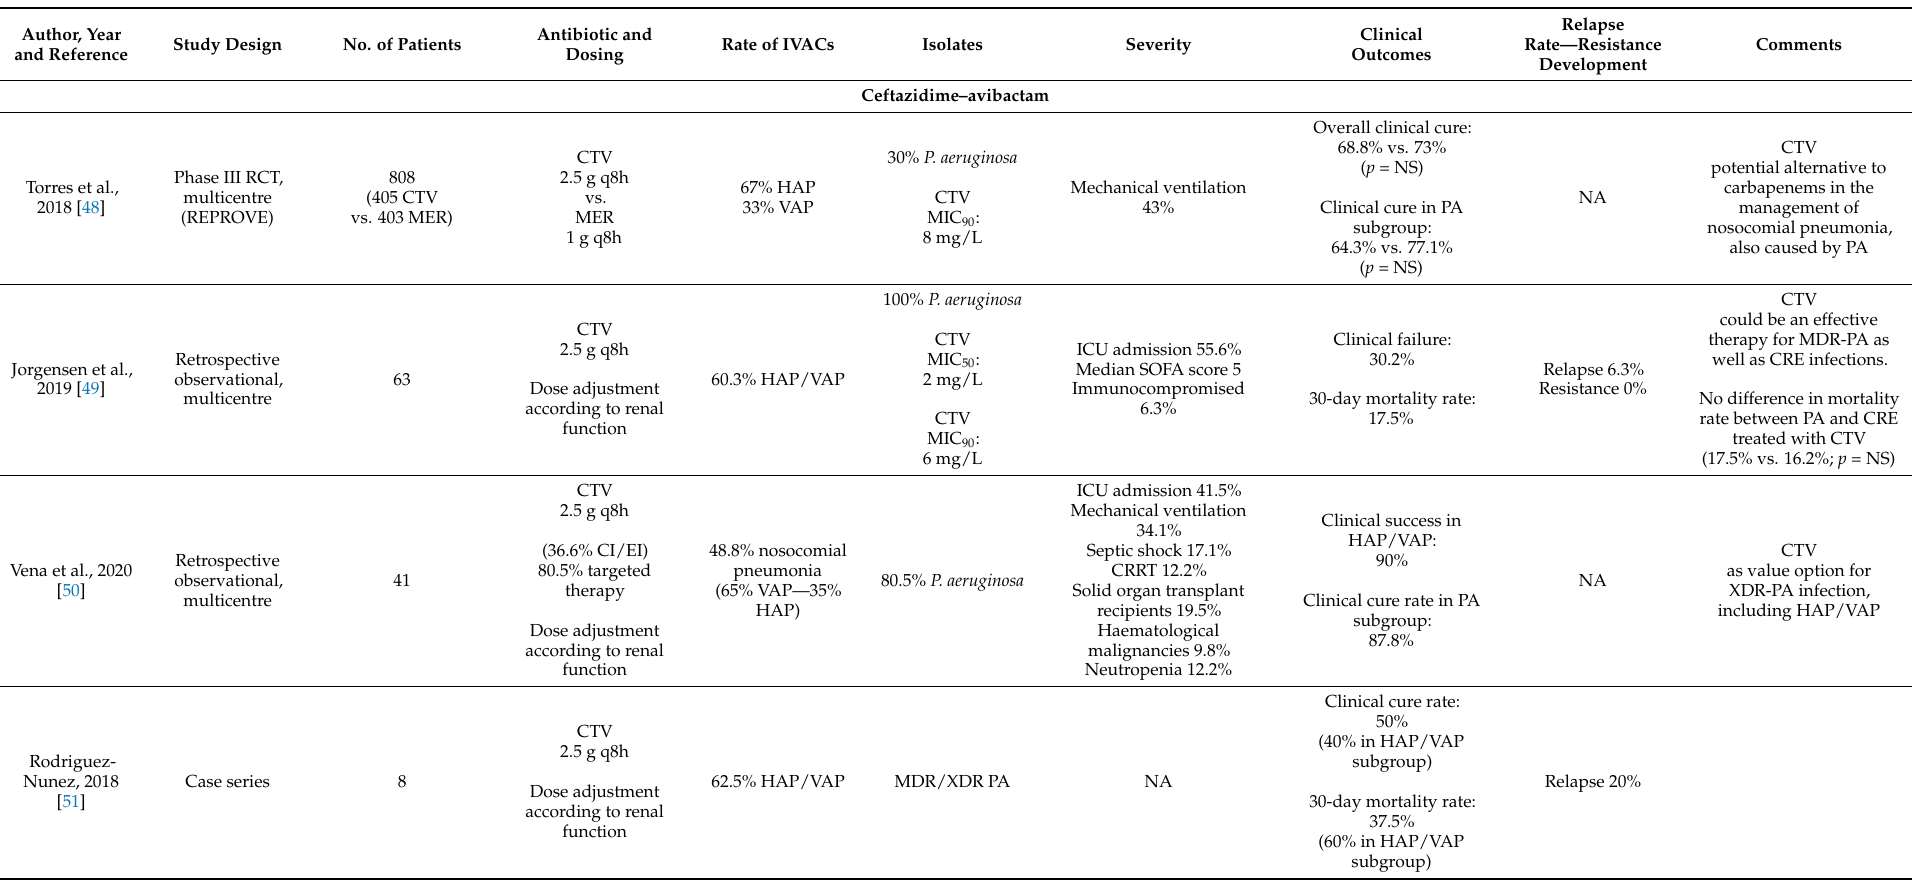
Table 3. Summary of the studies investigating the treatment of multidrug-resistant (MDR) metallo-beta-lactamase-negative GES-positive Pseudomonas